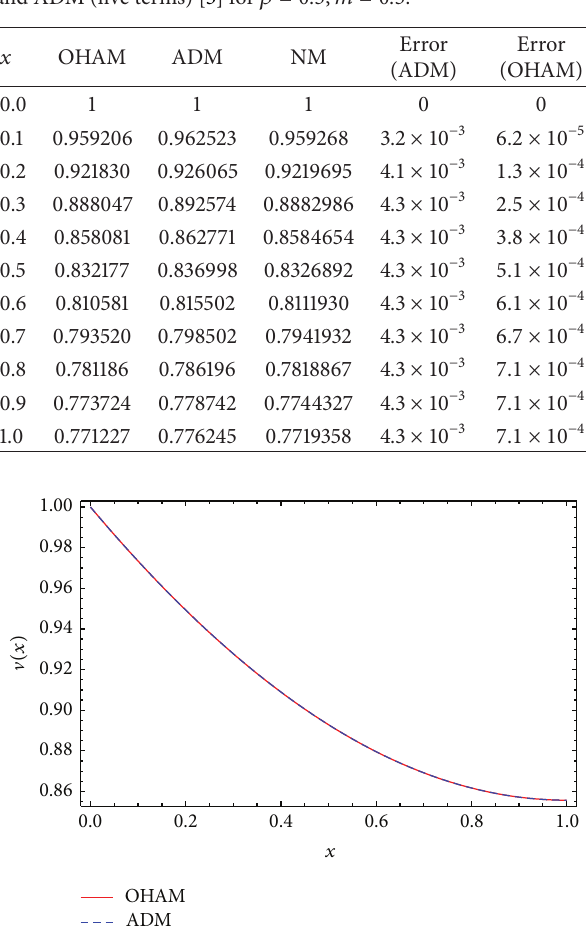
Table 1: Comparison of absolute error using OHAM (three terms) and ADM (five terms) [3] for 𝛽 = 0 . 5, 𝑚 = 0 . 5.